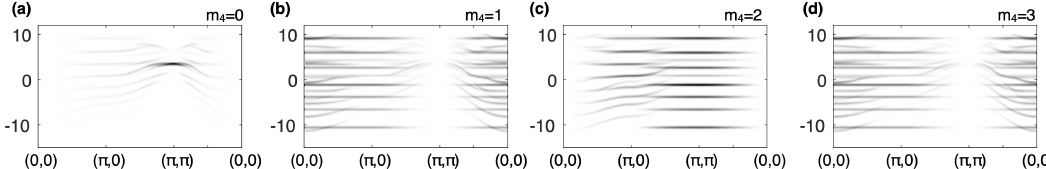
and 4 = 11 was used. We max